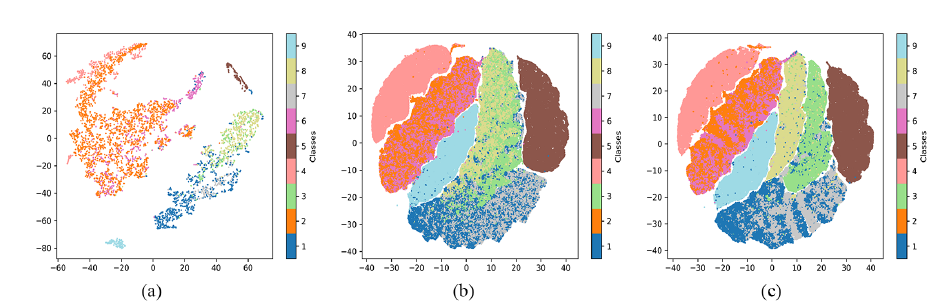
Figure 2. The 2D projection map based on generated samples before/after domain adaptation using SaGAAN: ( a ) the projection map of training samples; ( b ) the projection map of generated samples before domain adaptation; and ( c ) the projection map of generated samples after domain